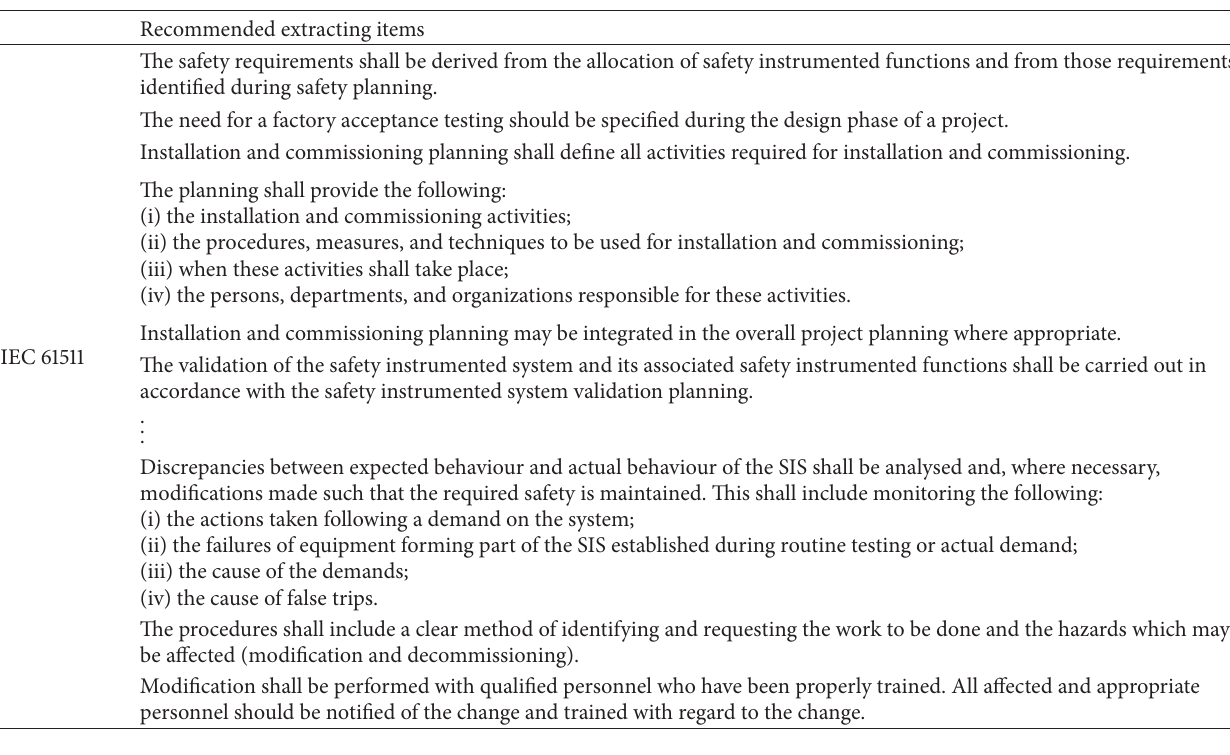
Table 3: The example of recommended extracting items from IEC